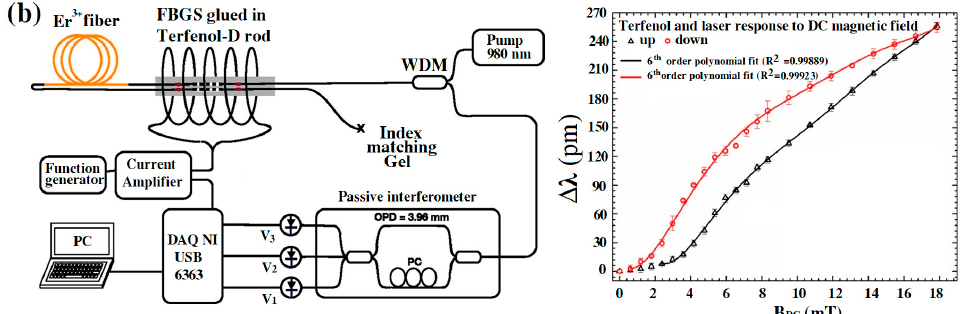
Figure 3. ( a ) Magnetic field sensor probe based on fiber Bragg gratings (FBG) and Terfenol-D rod and the performance of sensor [29] and ( b ) sensor sensing system based on FBG laser and Terfenol-D rod